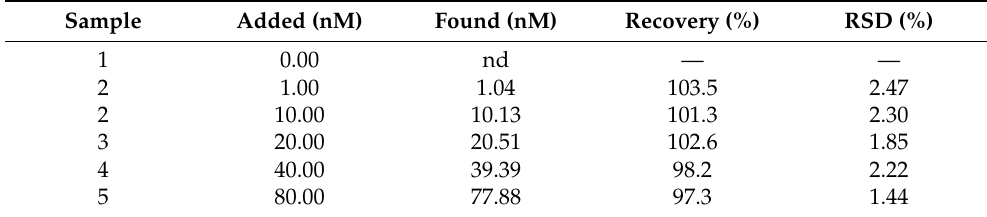
Table 2. Detection of BPA added in bottled water.